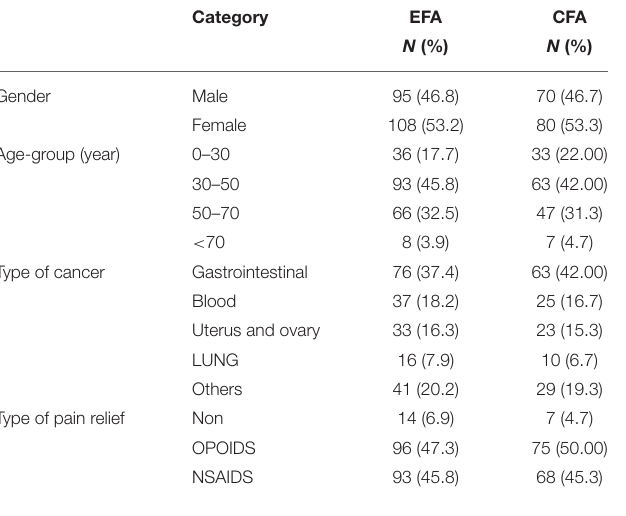
TABLE 1 | Rating of exploratory factor analysis (EFA) and confirmatory factor analysis (CFA) based on demographic